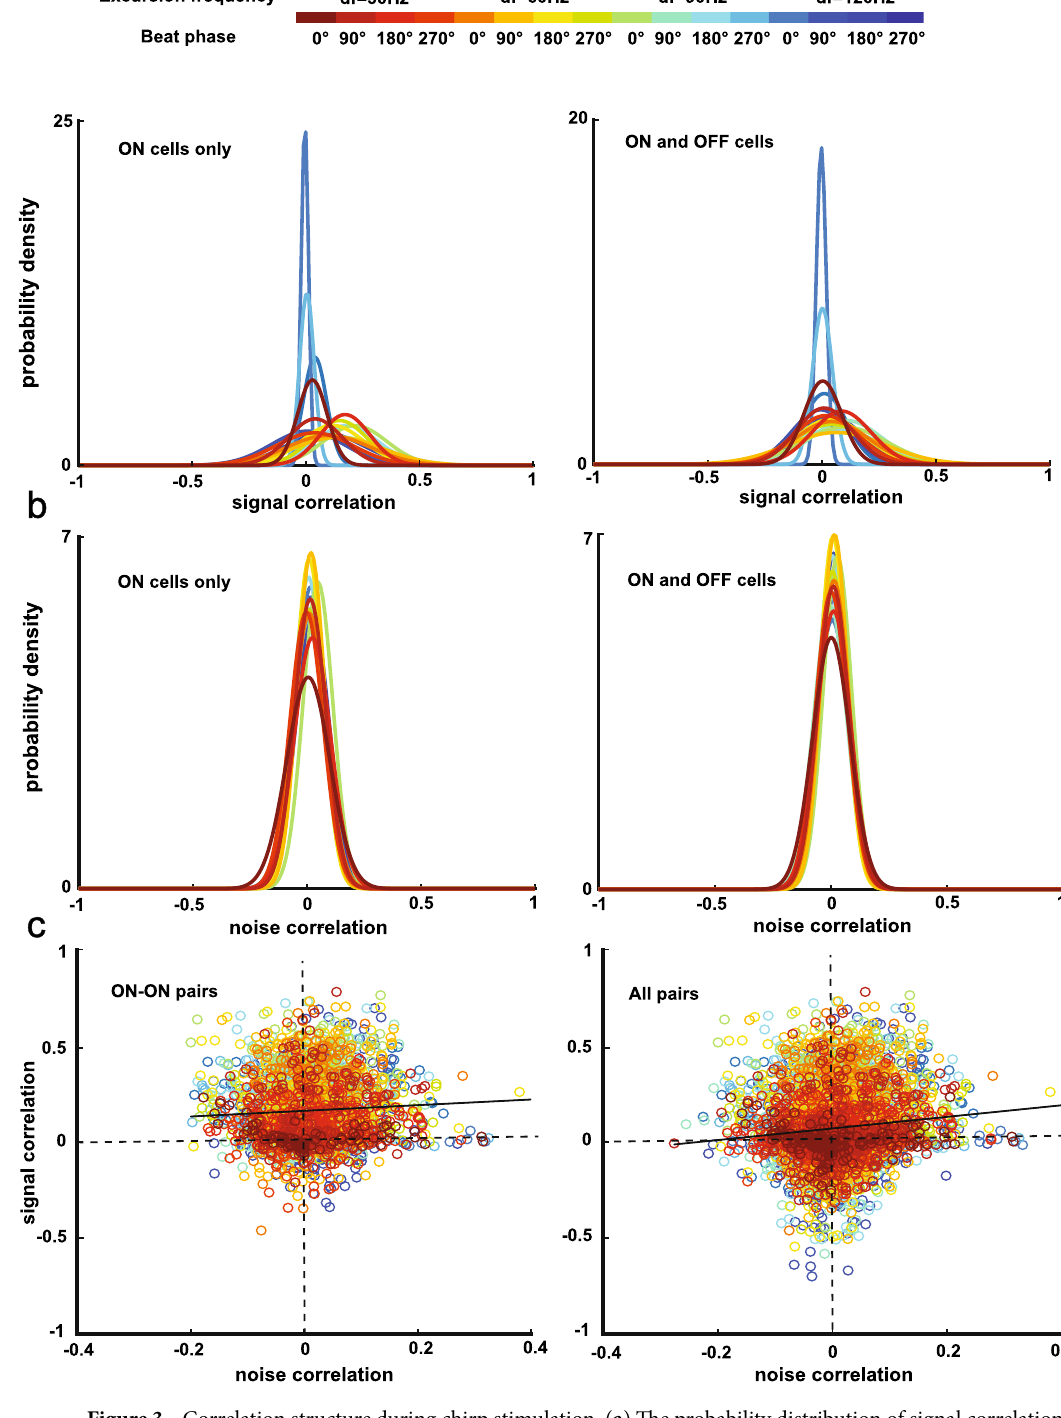
Figure 3. Correlation structure during chirp stimulation. ( a ) The probability distribution of signal correlations for each chirp stimulus waveform used. There were significant differences between the distributions for the population with only ON cells (left) and the population with both ON and OFF cells (right) (ON cells only: Friedman’s test, p = 4.0 × 10 –44 ; ON and OFF cells: Friedman’s test, p = 1.1 × 10 –16 ). ( b ) Same as ( a ) but for noise correlations. There were significant differences between the distributions for the population with ON cells only (Friedman’s test, p = 0.020), while there were no significant differences between the distributions for the population with both ON and OFF cells (Friedman’s test, p = 0.17). ( c ) Noise correlations of ON-ON pairs only (left) and of all pairs (right) plotted against signal correlations of the same pairs. There were positive relationships between signal and noise correlations for ON–ON pairs and for all pairs (ON–ON pairs: linear regression, r = 0.060, p = 1.3 × 10 –3 ; all pairs: linear regression, r = 0.11, p = 6.0 × 10 –15